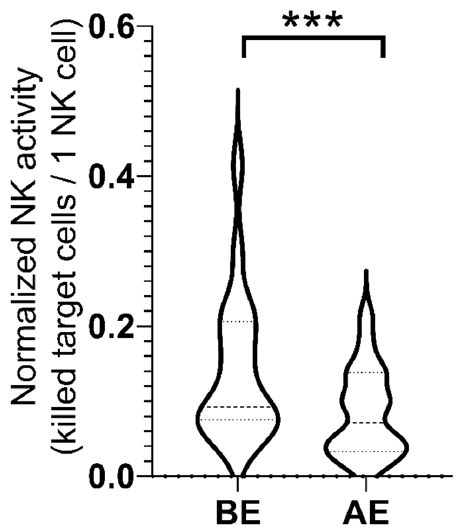
Figure 2. NK cell function. NK cells were co-incubated with K562 cells at 20:1 effector/target ratio for 2 h at 37 °C. The percentage of killed K562 cells were analyzed. The NK activity values were normalized to the absolute number of NK cells (number of killed K562 target cells/number of NK cells in the sample). *** p < 0.001 (Wilcoxon test).